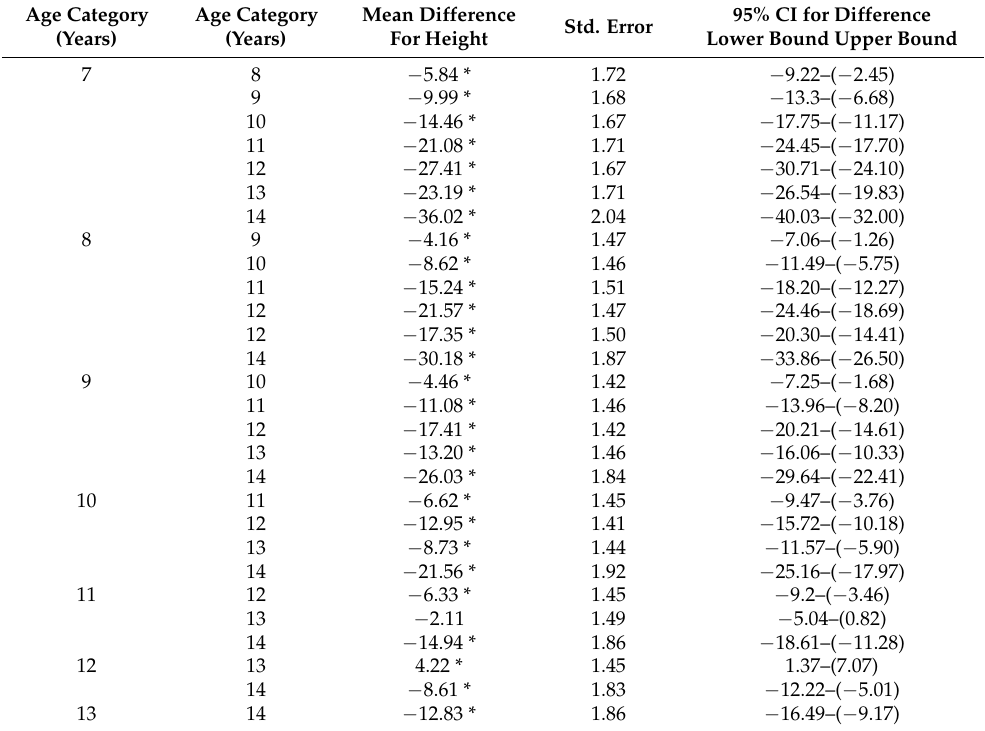
Table 4. Pairwise comparisons for